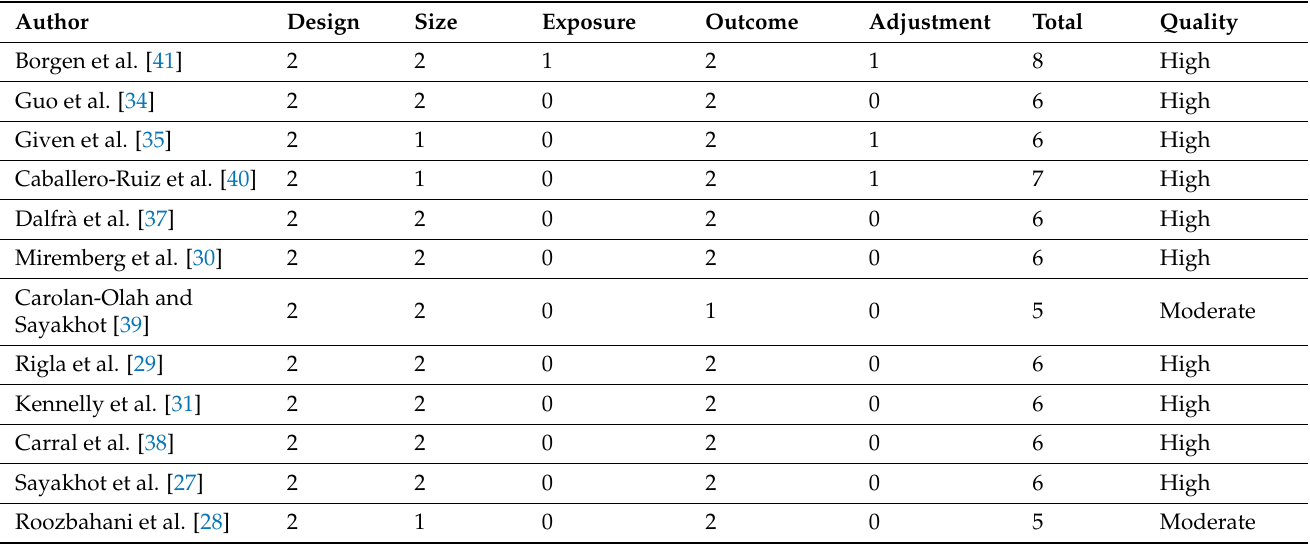
Table 1. Quality scores for included RCTs in the review using the ErasmusAGE quality assessment tool.